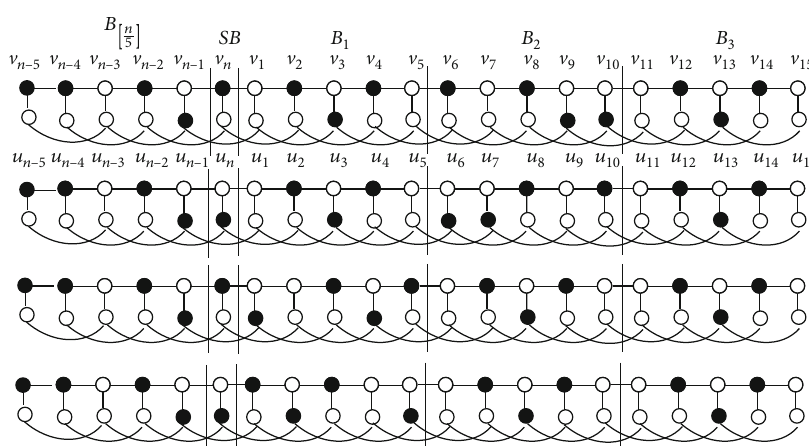
, B , SB with 8 guards. 1 2